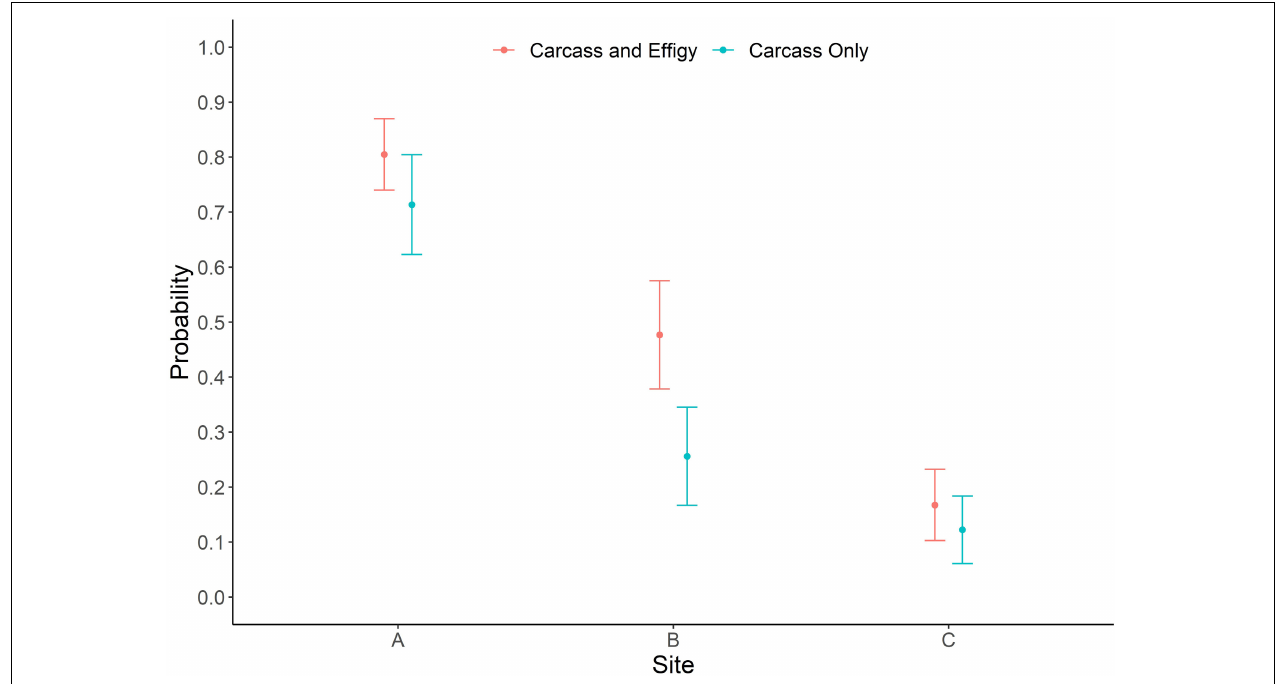
FIGURE 6 | Probability of beaching by deployment site (A, B, and C) ± 1 standard error for carcass and effigy and carcass only models.